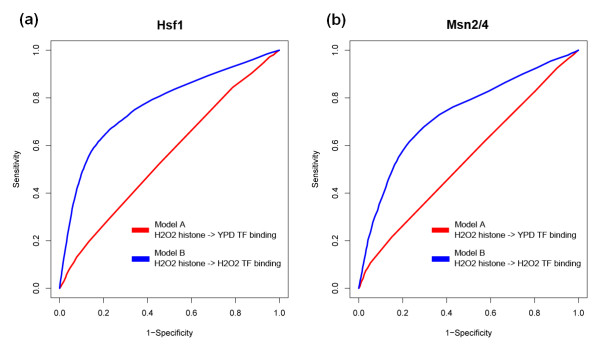
Condition specificity of the chromatin model for TF target prediction. (a, b) ROC curves showing the performance of two chromatin models in predicting target genes of HSF1 (a) and the MSN2/4 complex (b). The model (model B) using histone modifications in the H2O2 condition is better at predicting target genes in the H2O2 condition (blue curve) than in YPD medium (model A; red curve), which indicates condition specificity of chromatin modifications and TF target genes.